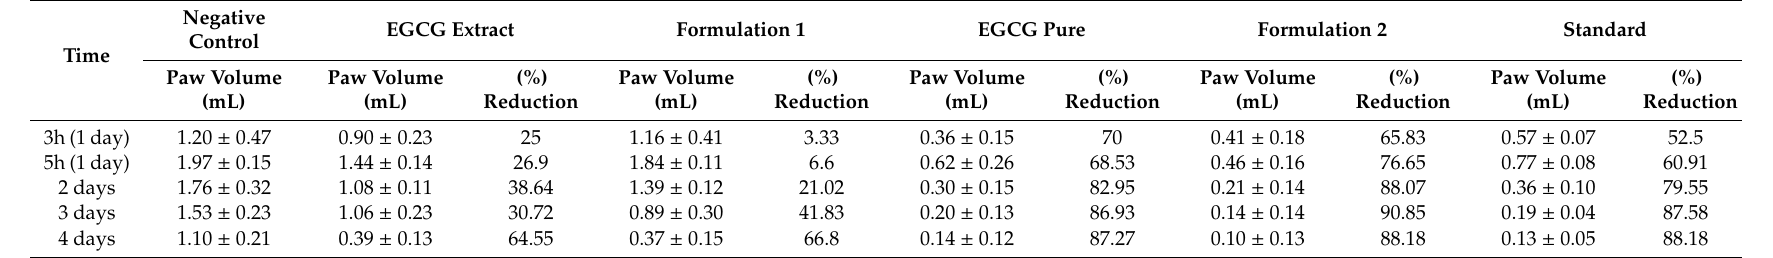
Table 3. Anti-inflammatory study of green tea extract, pure EGCG and its phytosomal